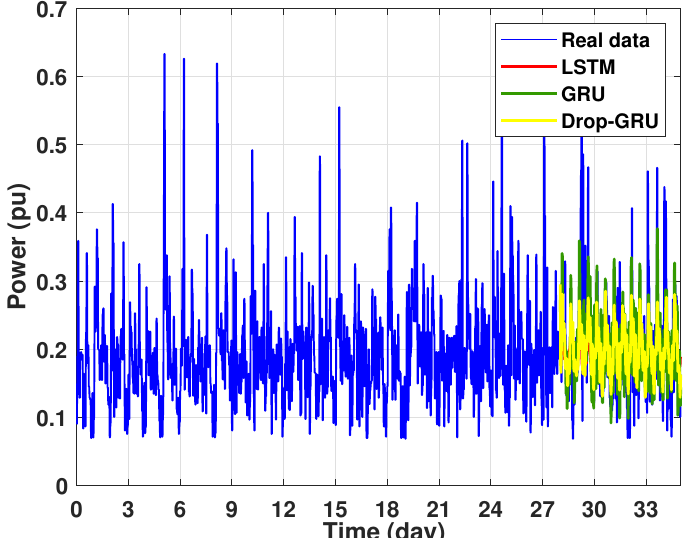
Figure 16. Prediction results of 7 days power consumption for the first area.